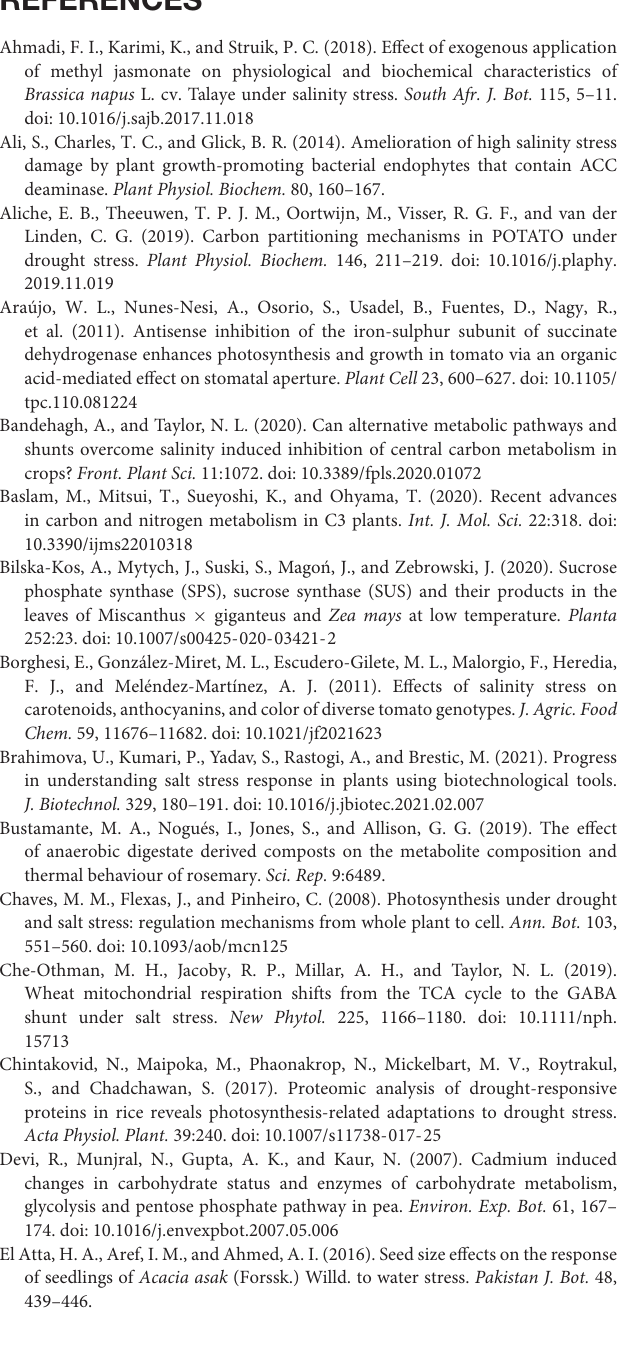
Supplementary Figure 2 | Principal component analysis of enzyme activity and gene expression in photosynthesis, starch and sucrose metabolism, and EMP and TCA cycle indexes of G. uralensis seedlings under four treatments (CK, CK + G2, S, and S + G2). (A) Ordering distribution and interpretation of the 12 principal components related to enzyme activity. (B) The contribution of the variables related to photosynthetic pigments content, starch and sucrose metabolism, and EMP and TCA cycle indexes to the principal components. (C) Ordering distribution and interpretation of the 12 principal components related to gene expression. (D) The contribution of the variables related to carbon fixation in the